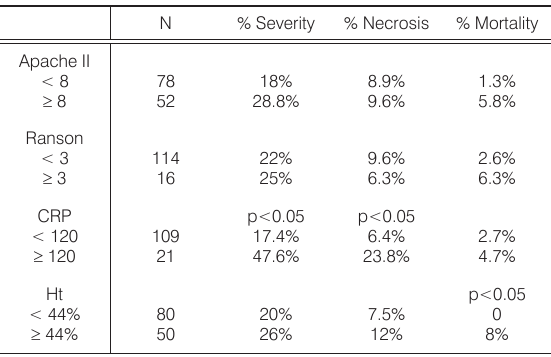
Table 1. Bivariate analysis of EPMs and severity, necrosis and mortality.